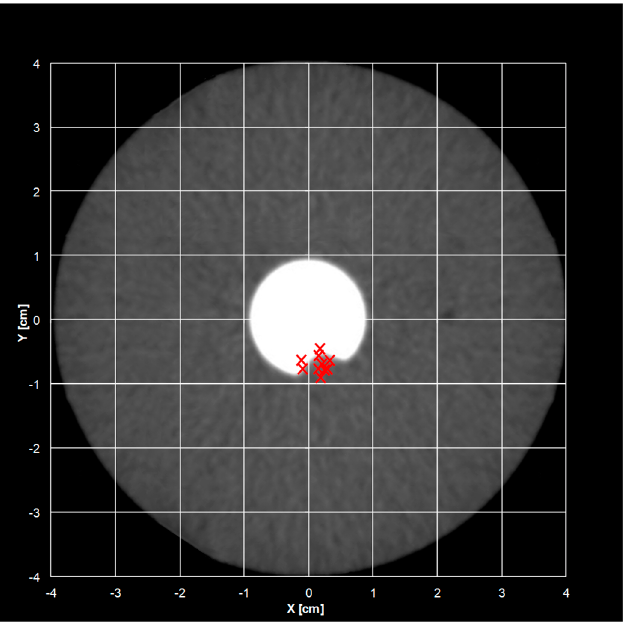
Figure 14. Cross ‐ section of the insulator in the X ‐ ray image with marked points of the defect located using the method of associated sensors. using the method of associated